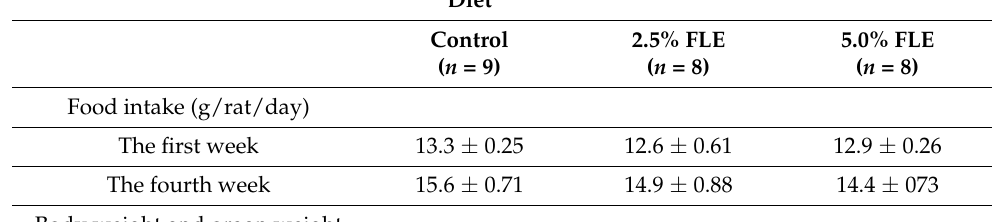
Table 2. Effects of FLE on physical and plasma parameters after four weeks of HFD feeding.